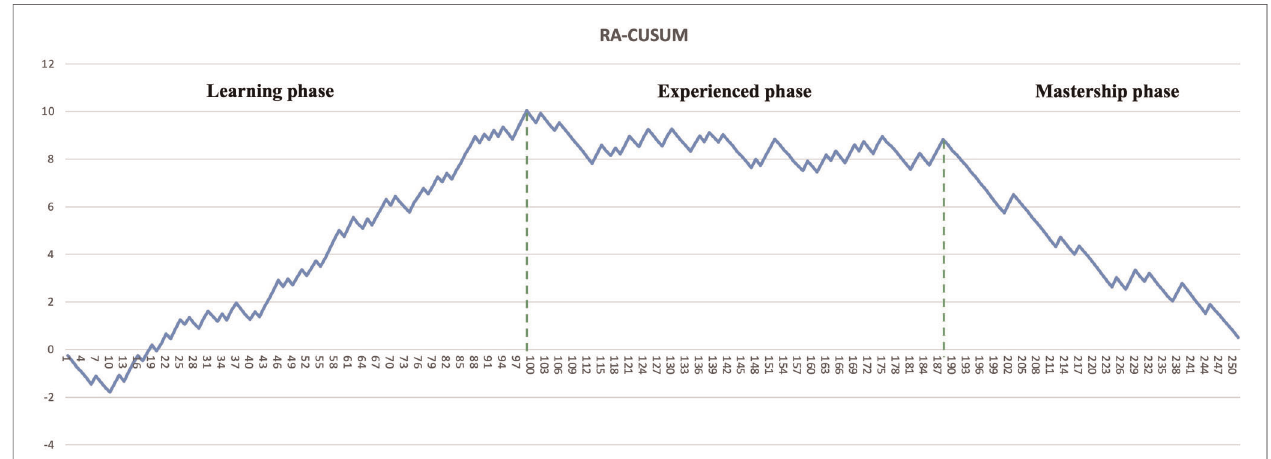
FIGURE 1 | CUSUM curve of operation time (CUSUMOT).